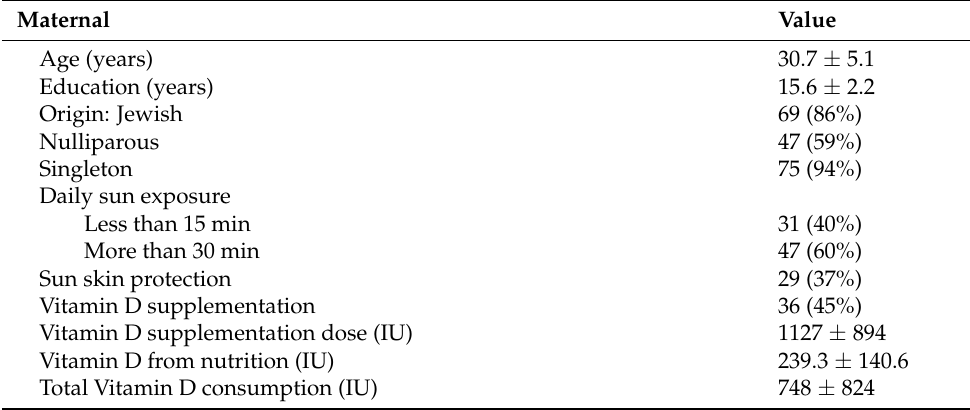
Table 1. Patients’